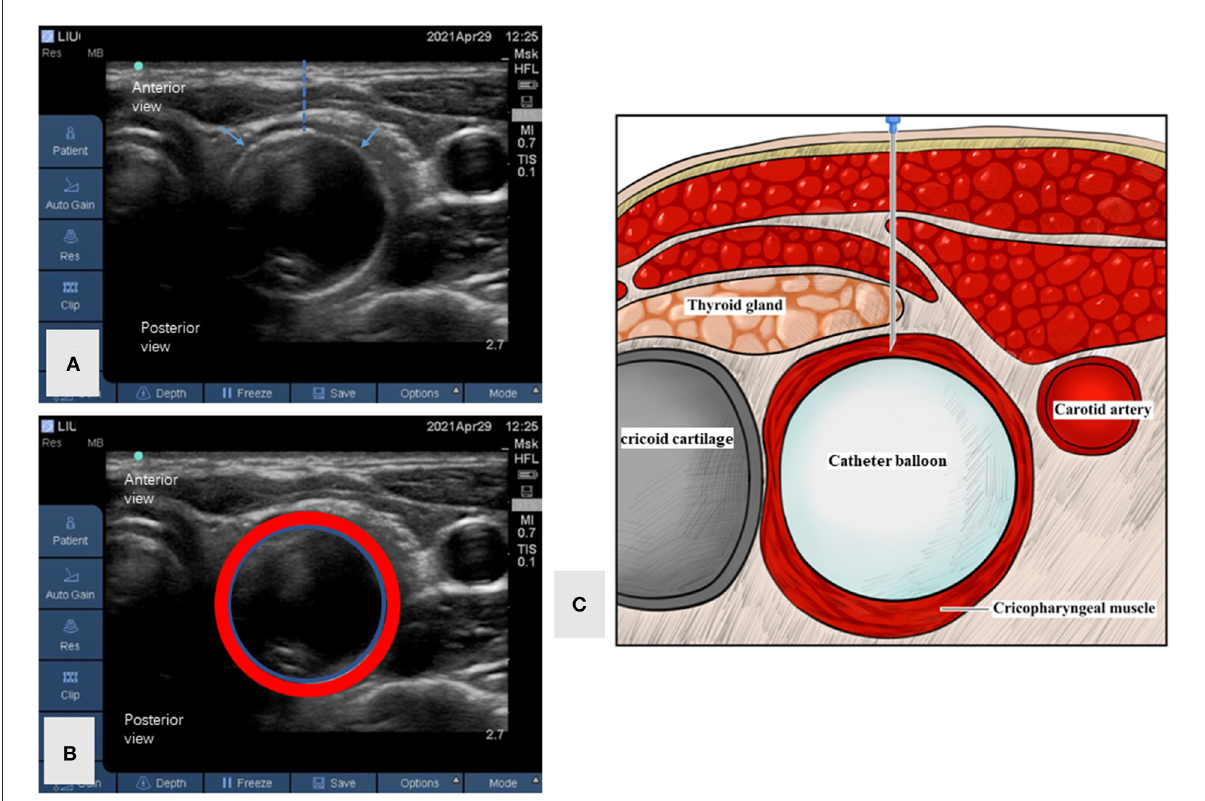
FIGURE2 Ultrasound imaging of the cricopharyngeal muscle during the operation. (A) The ultrasound imaging of the cricopharyngeal muscle during the operation. The blue arrow shows the cricopharyngeal muscle under catheter balloon guidance. The dotted line indicates the expected injection path. (B) The ultrasound imaging of the cricopharyngeal muscle and catheter balloon with margins drawn. The red circle shows the cricopharyngeal muscle. The blue circle shows the catheter balloon. (C) The cartoon of cricopharyngeal muscle and adjacent